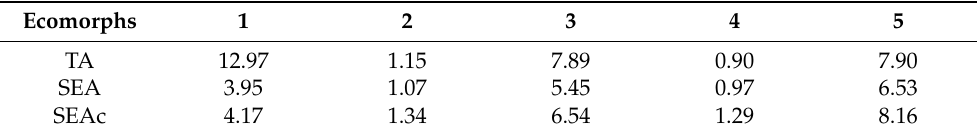
Table 3. Niche overlap estimates (NicheROVER package) showing the posterior probabilities ( α = 0.95) that individuals from rows will be found within the niches indicated by the column header. Results (%) are provided for sympatric Garra ecomorphs from the Sore River (subset of 50–90 mm SL, n = 44).